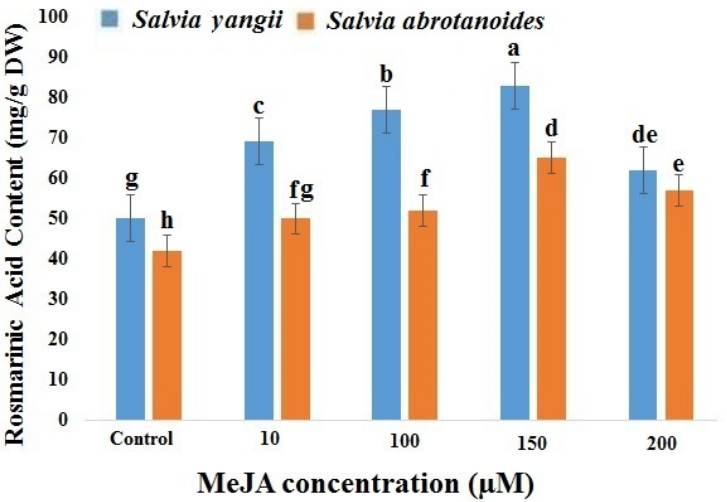
Figure 2. Concentration of rosmarinic acid in two species of Salvia (subgenus Perovskia Kar). Duncan’s test claims that bars labeled differently reflect statistical significance at the 1% level. Error bars represent the standard deviation of the data. Means followed by the same letters in each column are not significantly different ( p < 0.01).